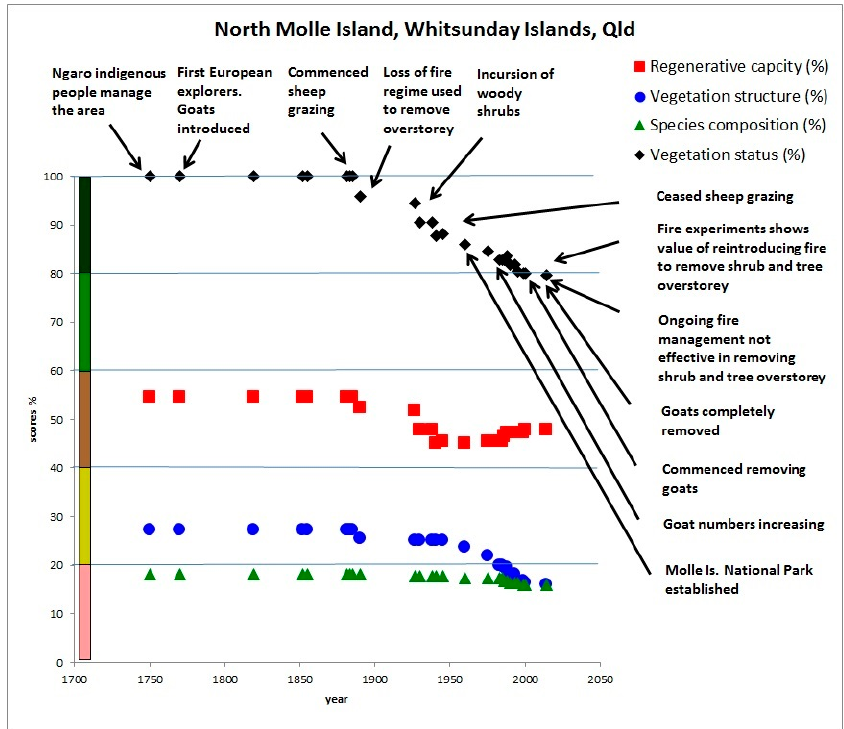
Figure 8. Case study 7: Conkerberry Paddock, Victoria River Research Station, tropical warm season wet agro-climate region, eucalypt open woodland.